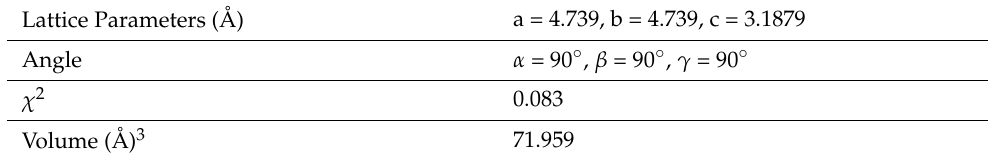
Table 1. Parameters of analysed XRD spectra.